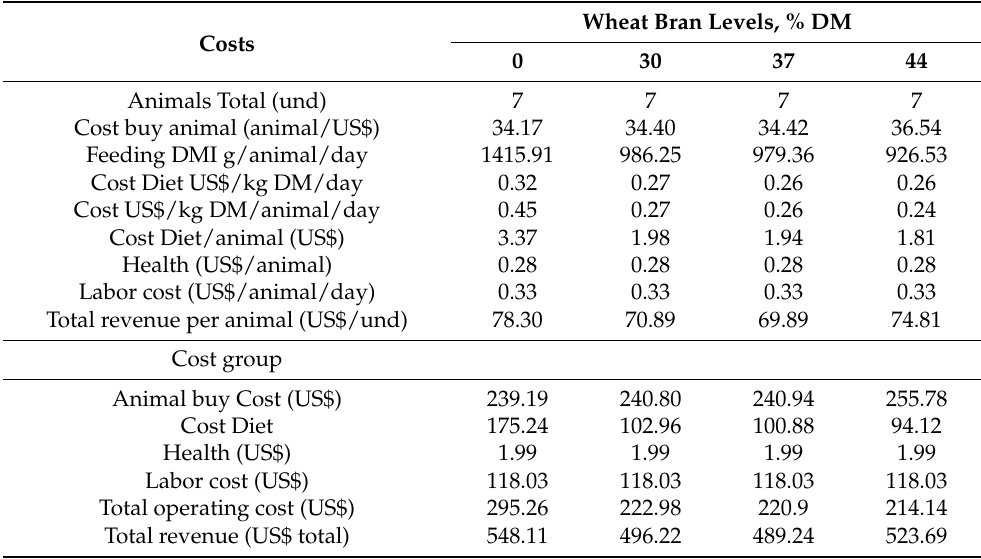
Wheat Bran Levels, %